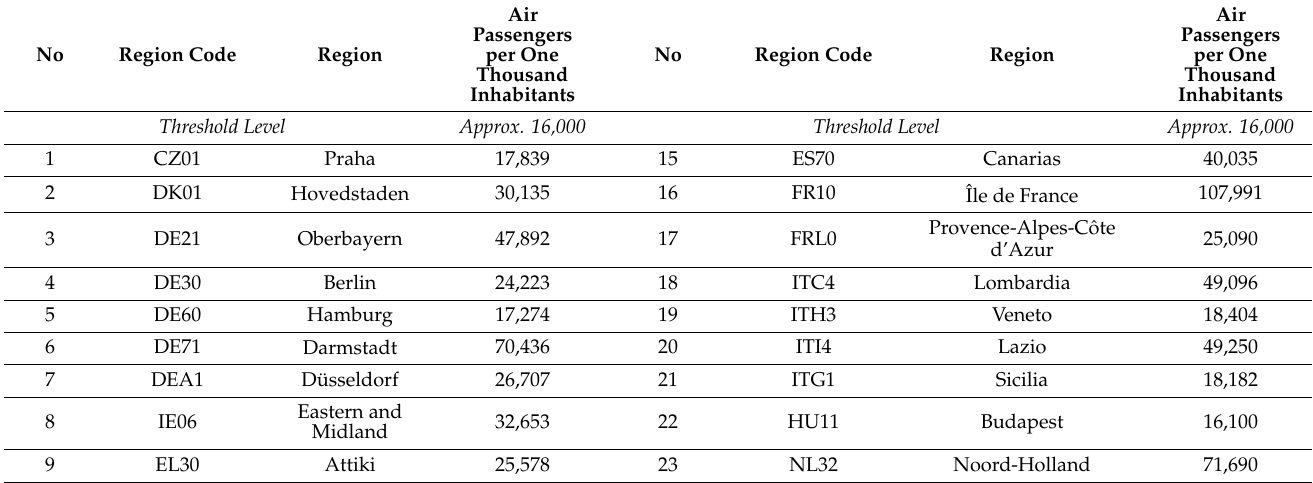
Table A4. EU NUTS 2 regions where air passengers per one thousand inhabitants exceeded 16,000 in